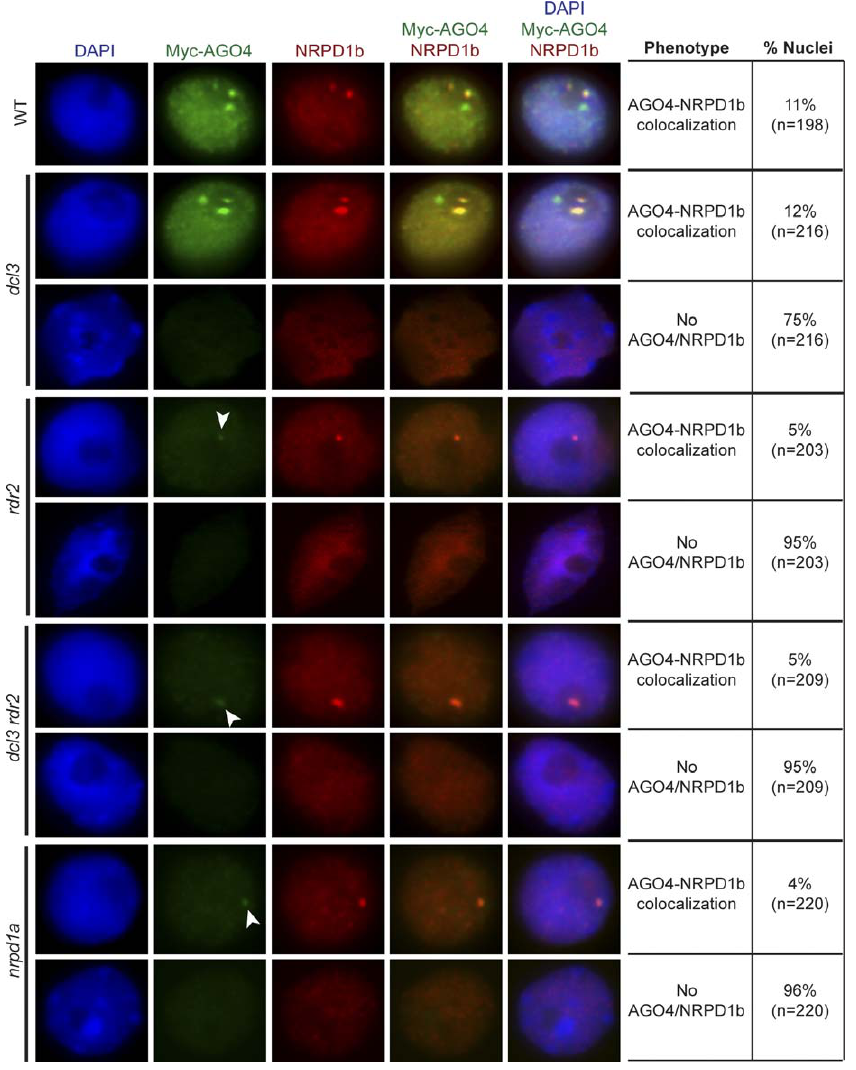
Figure 3. Presence of the AB-Body in Upstream RdDM Mutants Immunolocalization analysis of Myc-AGO4 and NRPD1b in wild type, dcl3 , rdr2 , dcl3 rdr2 , or nrpd1a nuclei. White arrows indicate the presence of a faintly staining Myc-AGO4 body that colocalized with NRPD1b. Two populations of nuclei are shown for each mutant: nuclei with and nuclei without AB- bodies.